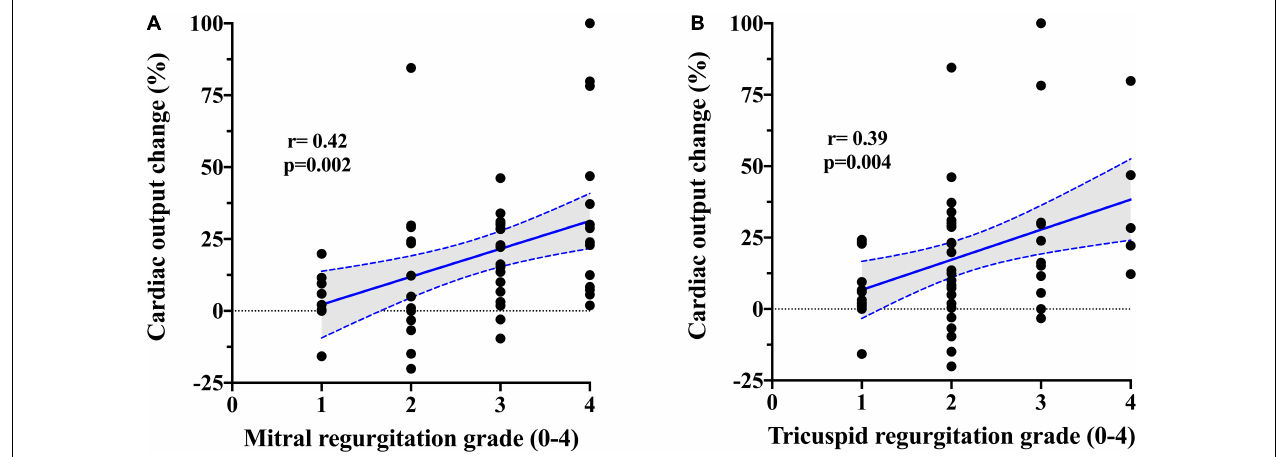
FIGURE 3 | Correlation between PDE5i-induced change in cardiac output and (A) mitral and (B) tricuspid regurgitation severity.